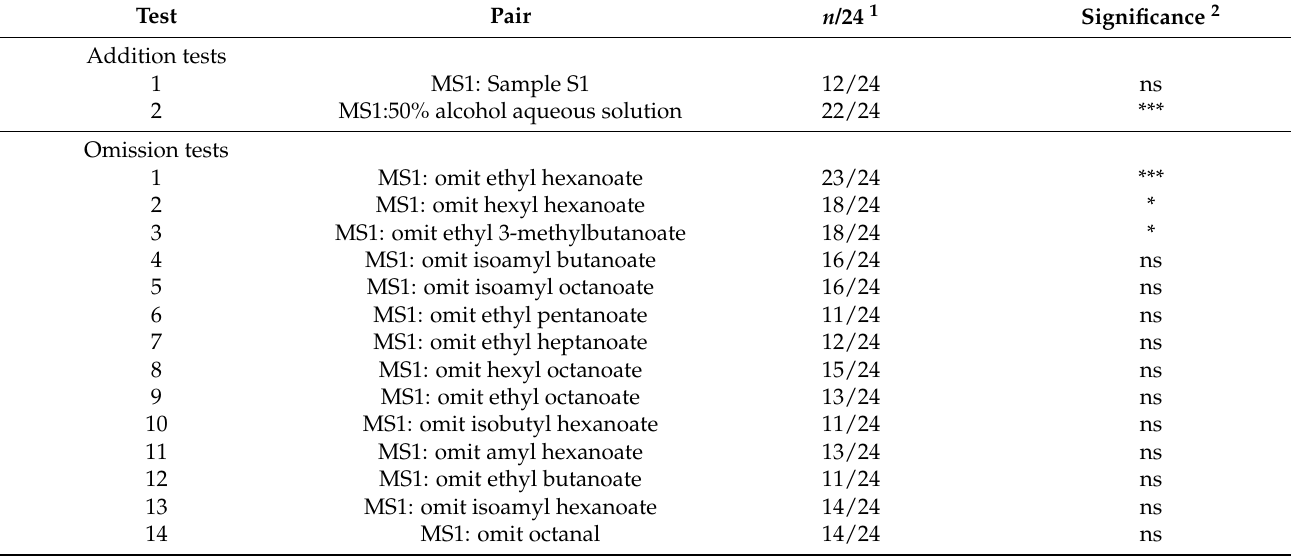
Table 3. Addition and omission tests via two-alternative forced choice (2-AFC) by 24